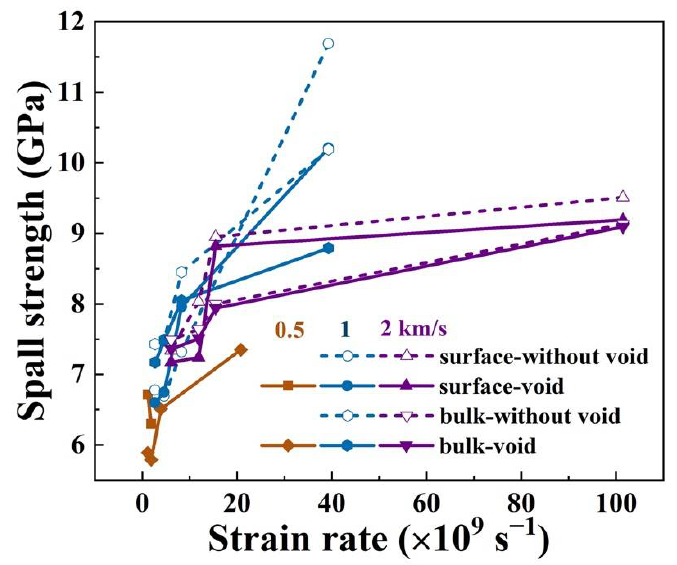
Figure 11. Free surface velocity profile of the samples. Both axes are normalized. T normalized = t × 2 v 0 /L z .